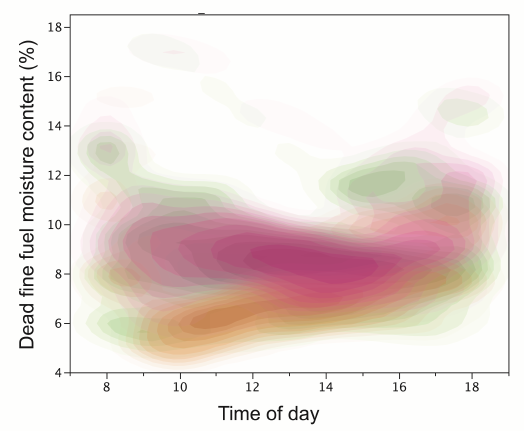
Figure 3. Non-parametric bivariate density of the estimated dead fine (1-h) fuel moisture content in CL (green), PP (orange), and BA (pink) stands during the selected 10-day